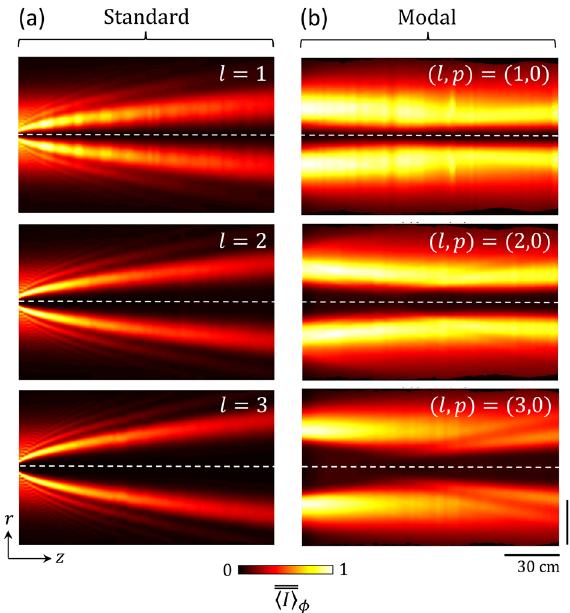
Figure 3: Beam propagation.